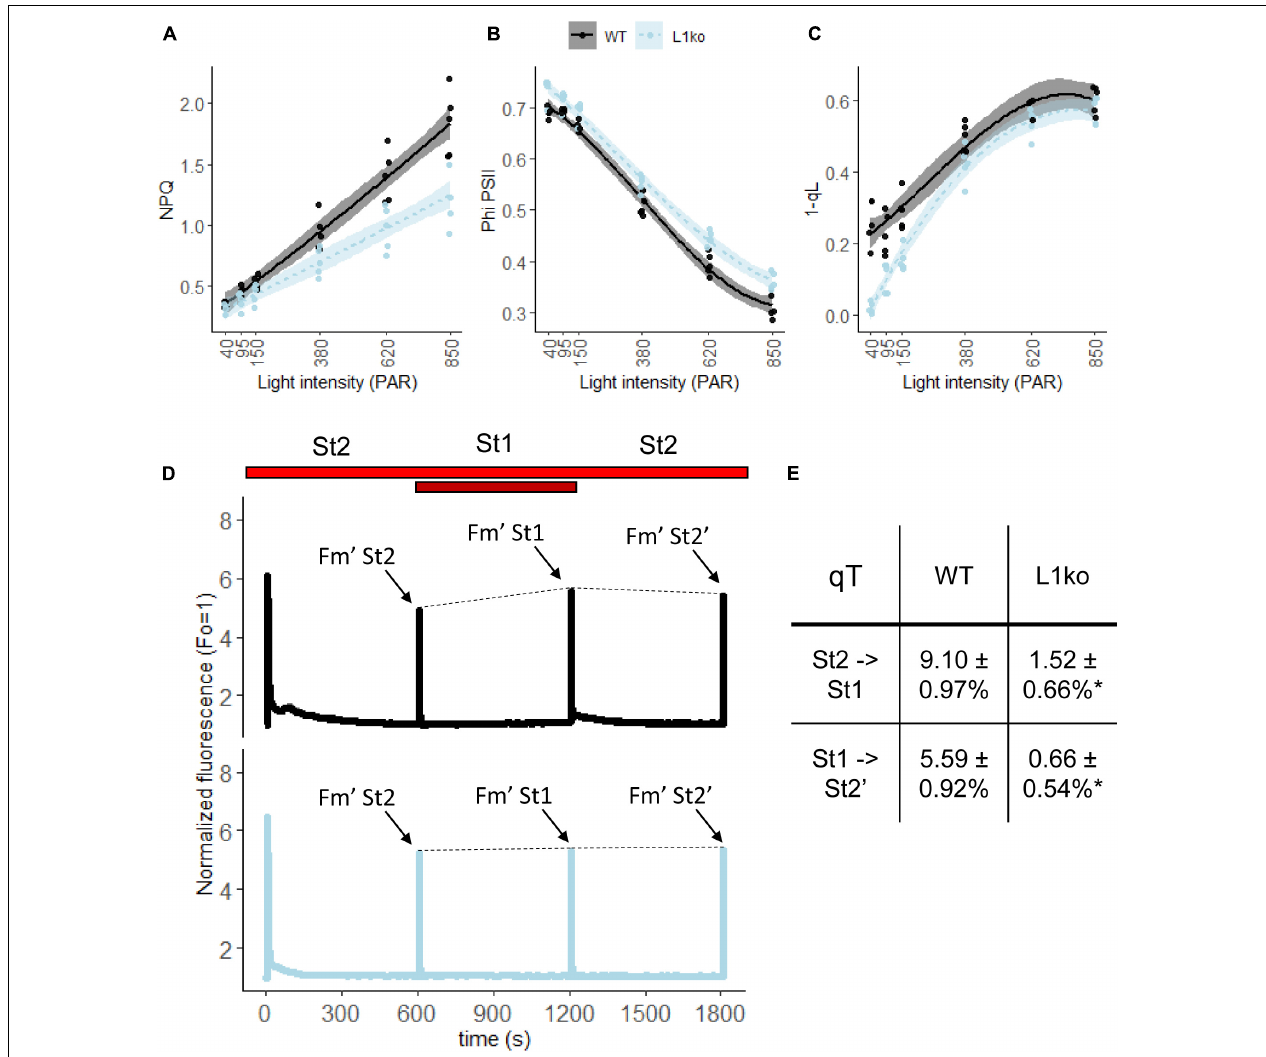
FIGURE 4 | Loss of LHCB1 alters the equilibrium of the LEF between PSII and PSI. The LEF was monitored by room temperature Chl fluorescence on adult WT (black lines) and L1ko (light blue lines) plants. The plants were exposed to a range of increasing light intensities, each lasting 5 min. (A) Non-photochemical quenching (NPQ), (B) quantum efficiency of PSII, referred as (cid:56) PSII in the main text. (C) Fraction of closed PSII centers estimated by the 1 qL parameter. Each experimental point is displayed as a dot. The measured points were fitted with a second-degree polynomial function for NPQ, a third-degree polynomial for (cid:56) PSII and 1-qL to visually represent the data distribution and the standard error for WT (the black line and the gray area) and L1ko (the blue dotted line and the light blue area). Post hoc analysis of the models shows that there is a significant difference between L1ko and WT ( p < 0.001). (D) Chl a fluorescence traces measured during shifts from State 2 (St2) to State 1 (St1), light and back. The line represents the average fluorescence and the area the standard deviation ( n = 3) for WT (upper, the black line) and L1ko (lower, the blue line). The bars at the top indicate illumination with red (shown in red) and far-red (dark red) light. The dashed line connecting the Fm’ peaks was added to highlight the state transitions. (E) qT values calculated as (Fm’St1-Fm’St2)/Fm’St2 ± SD ( n = 3), the peaks used for the calculation are highlighted in (D) , and the values indicated with an * are statistically different ( p <